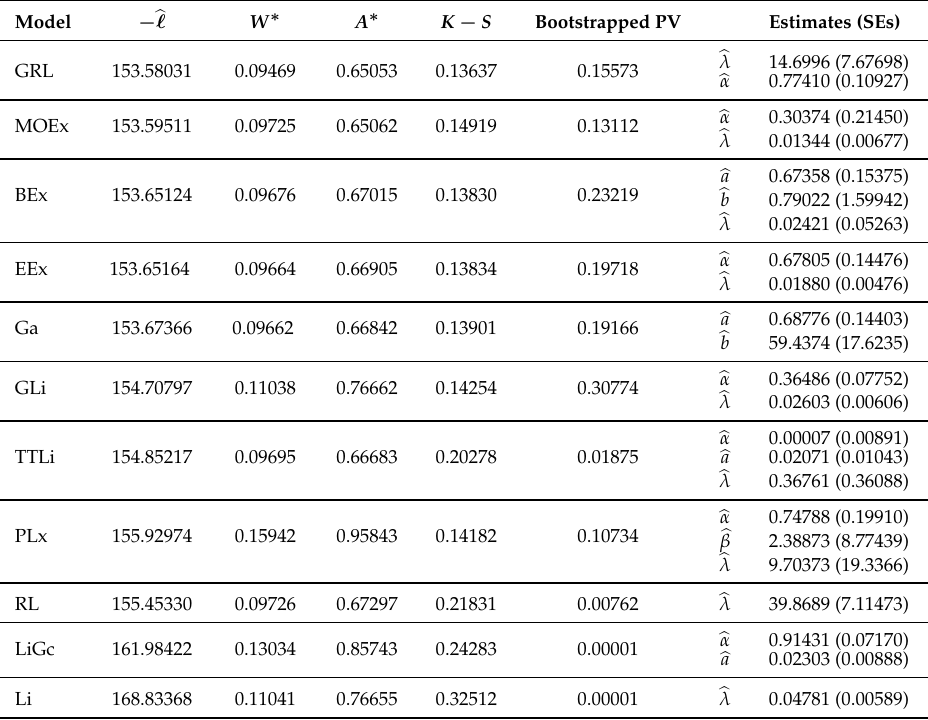
Table 12. Goodness-of-fit statistics, MLEs and SEs, for leukemia data.